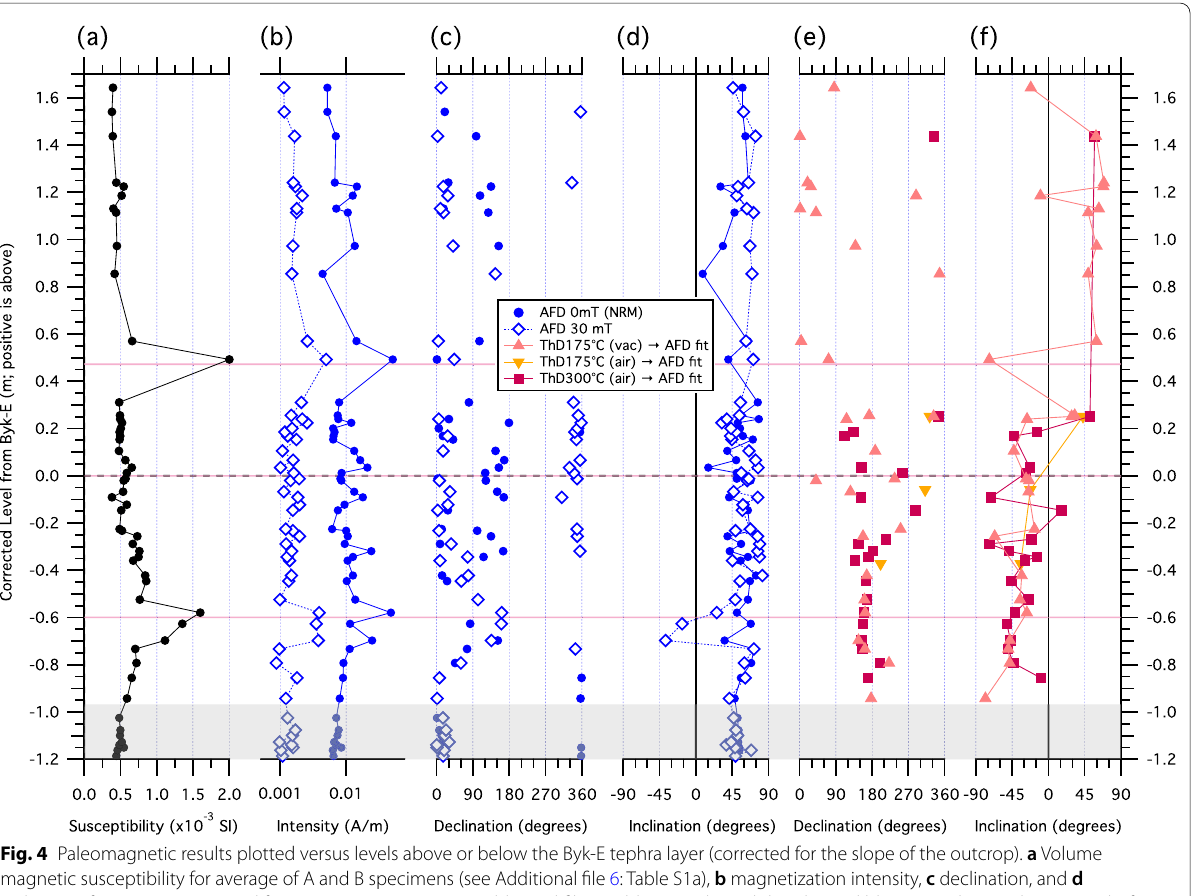
Fig. 4 Paleomagnetic results plotted versus levels above or below the Byk-E tephra layer (corrected for the slope of the outcrop). a Volume magnetic susceptibility for average of A and B specimens (see Additional file 6: Table S1a), b magnetization intensity, c declination, and d inclination for A specimens used for PAFD experiments (see Additional file 6: Table S1a). Blue solid circles and blue open diamonds are NRM before demagnetization and after AFD at 30 mT, respectively. e Declination, and f inclination for samples used for PAFD experiments following thermal demagnetization. Pink triangles are the results of PCA linear fitting on PAFD results following PThD experiments up to 175 °C in vacuum. Orange inverted triangles and red squares are the results of PCA linear fitting on PAFD results following PThD experiments at 175 °C and 300 °C in air, respectively. Three tephra layers identified in this study are shown as horizontal lines. For the results of PCA, only samples yielding MAD less than 15° are shown. Gray shading for levels between 95 cm and 120 cm represents the interval with no reliable magnetization due to unavailability of − − thermal demagnetization followed by PAFD